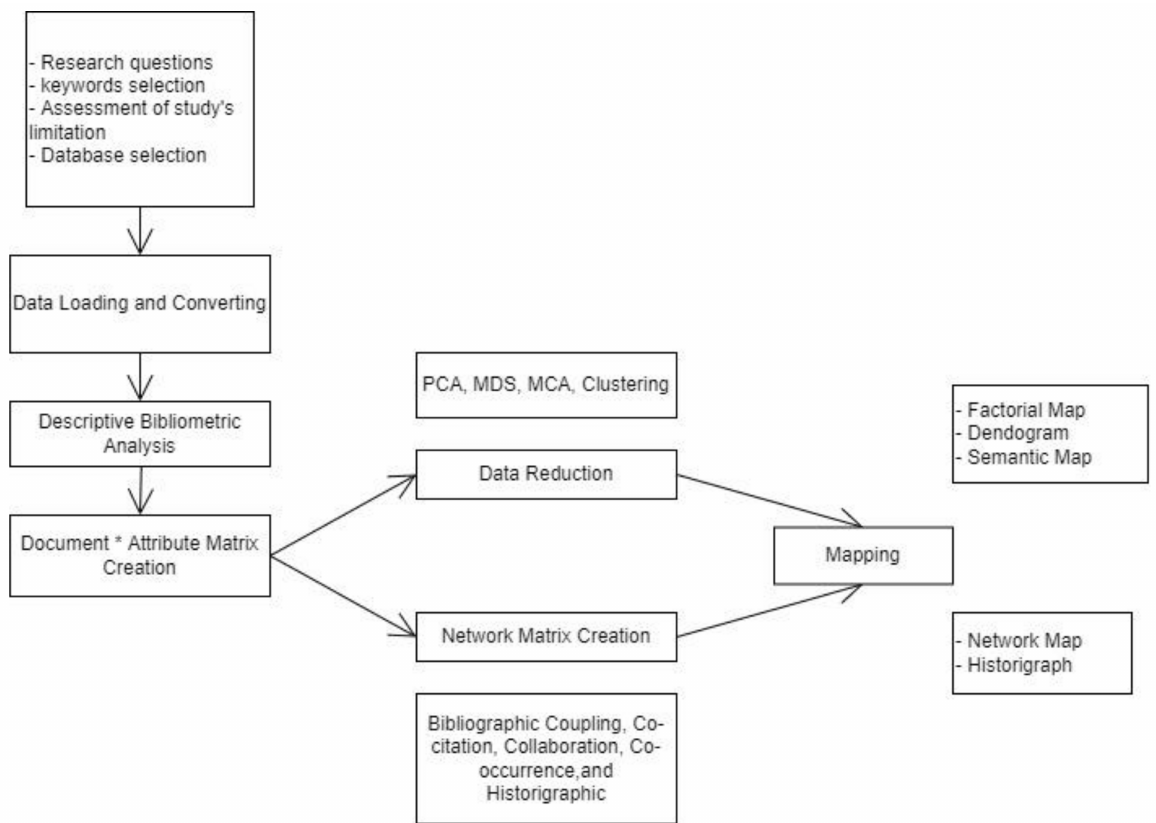
Figure 2. Protocol of a systematic literature review.